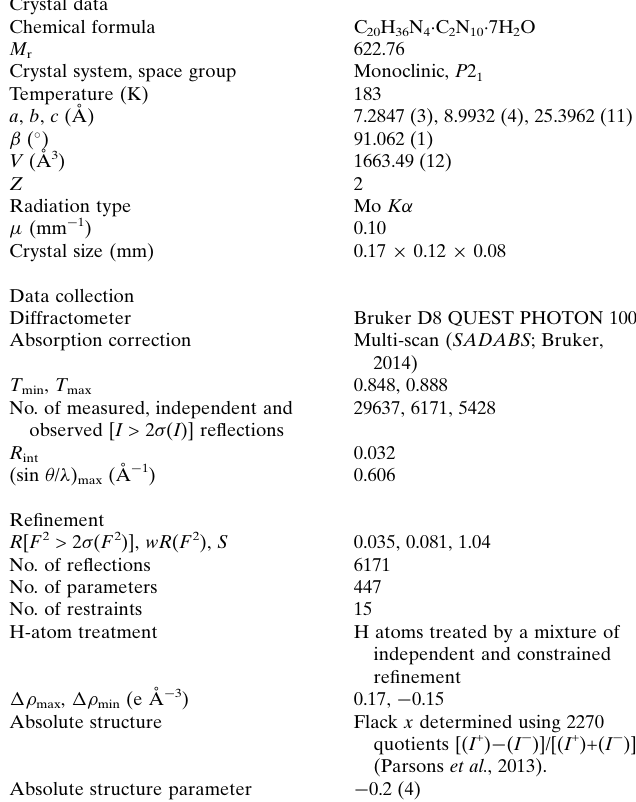
Table 2 Experimental details.